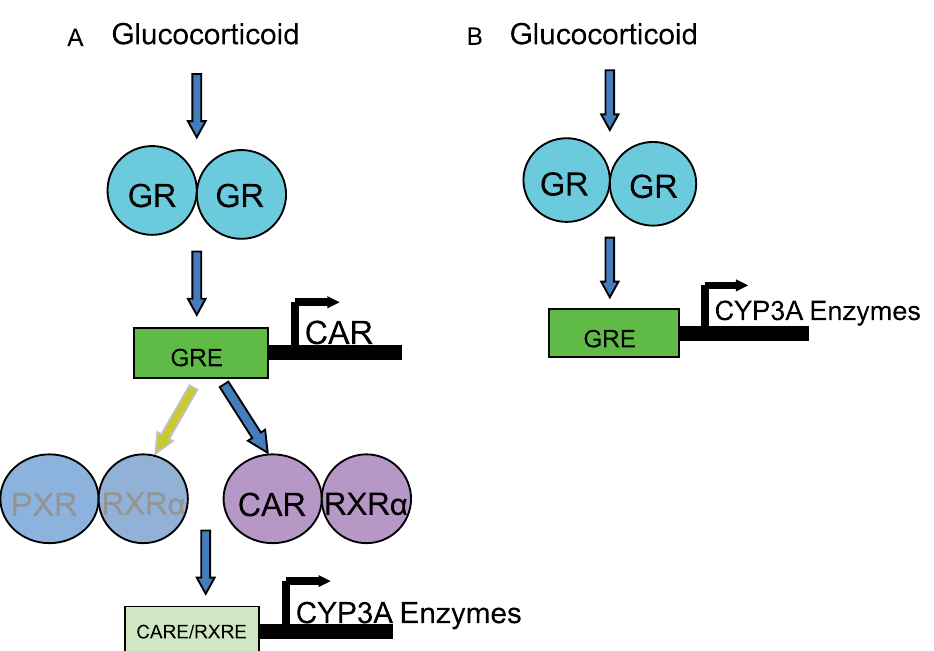
Figure 2. Possible mechanisms for the induction of CYP3A genes in lung cells. ( A ) Active glucocorticoid will bind to the glucocorticoid receptor (GR), which forms a homodimer and translocates to the nucleus. The homodimer binds to its response element (GRE) and induces the expression of either the pregnane X receptor (PXR) or the constitutive androstane receptor (CAR). CAR or PXR (though this receptor is not expressed in the lungs) forms a heterodimer with the retinoic X receptor alpha (RXR α ) which in turn induces the expression of the CYP3A enzymes via binding of the respective response-elements (CARE and/or PXRE). ( B ) Active glucocorticoid will bind to the glucocorticoid receptor (GR), which forms a homodimer and translocates into the nucleus. The homodimer binds to its response element (GRE) and induces the expression of CYP3A